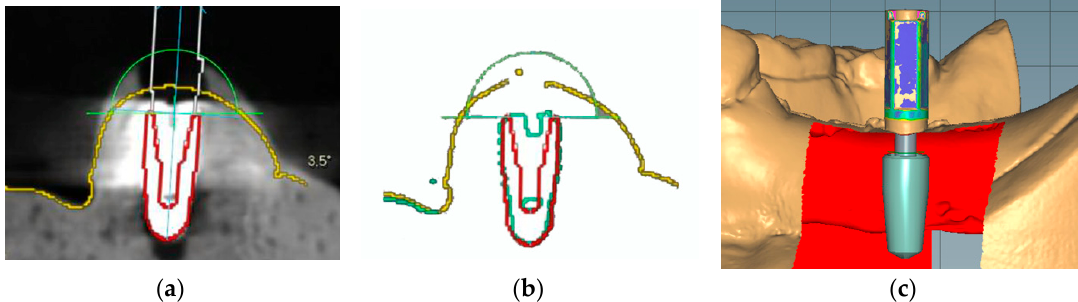
Figure 3. Implant detection methods. ( a ) Manual matching of a virtual implant image to the position of the radiographic image of the actual implant. ( b ) Manual matching of a virtual implant image to the position of the reconstructed mesh image of the actual implant. ( c ) Automatic creation of the virtual implant using scan abutment, digitization, and automatic image-matching.